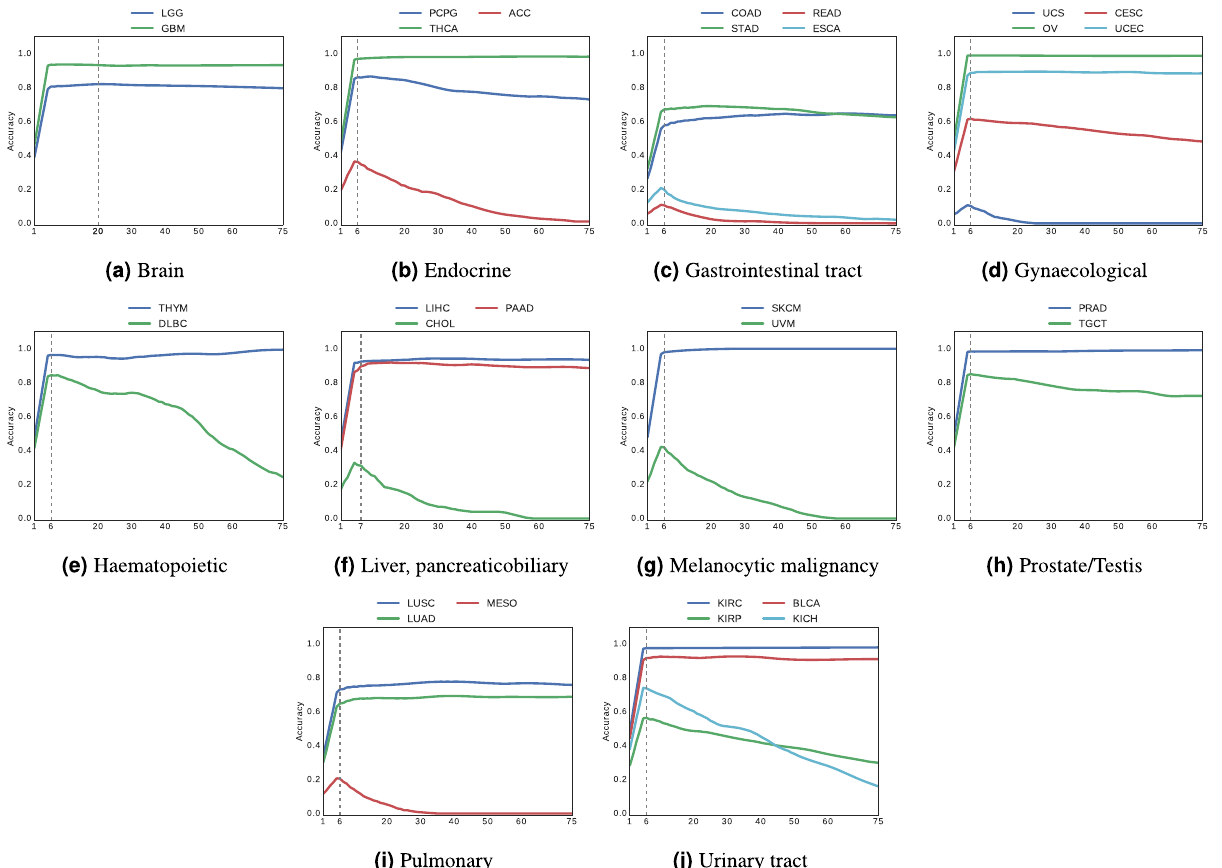
Fig. 3 Accuracy of vertical search for frozen sections. Vertical search in frozen sections slides from different anatomic sites ( a – j ) with at least two cancer